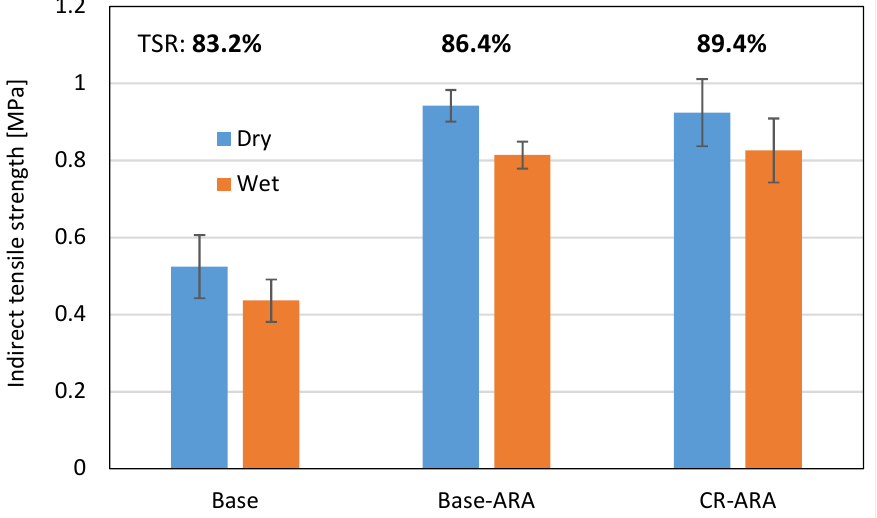
Figure 9. Indirect tensile strength ( ITS ) and tensile strength ratio before and after freeze-thaw cycle.